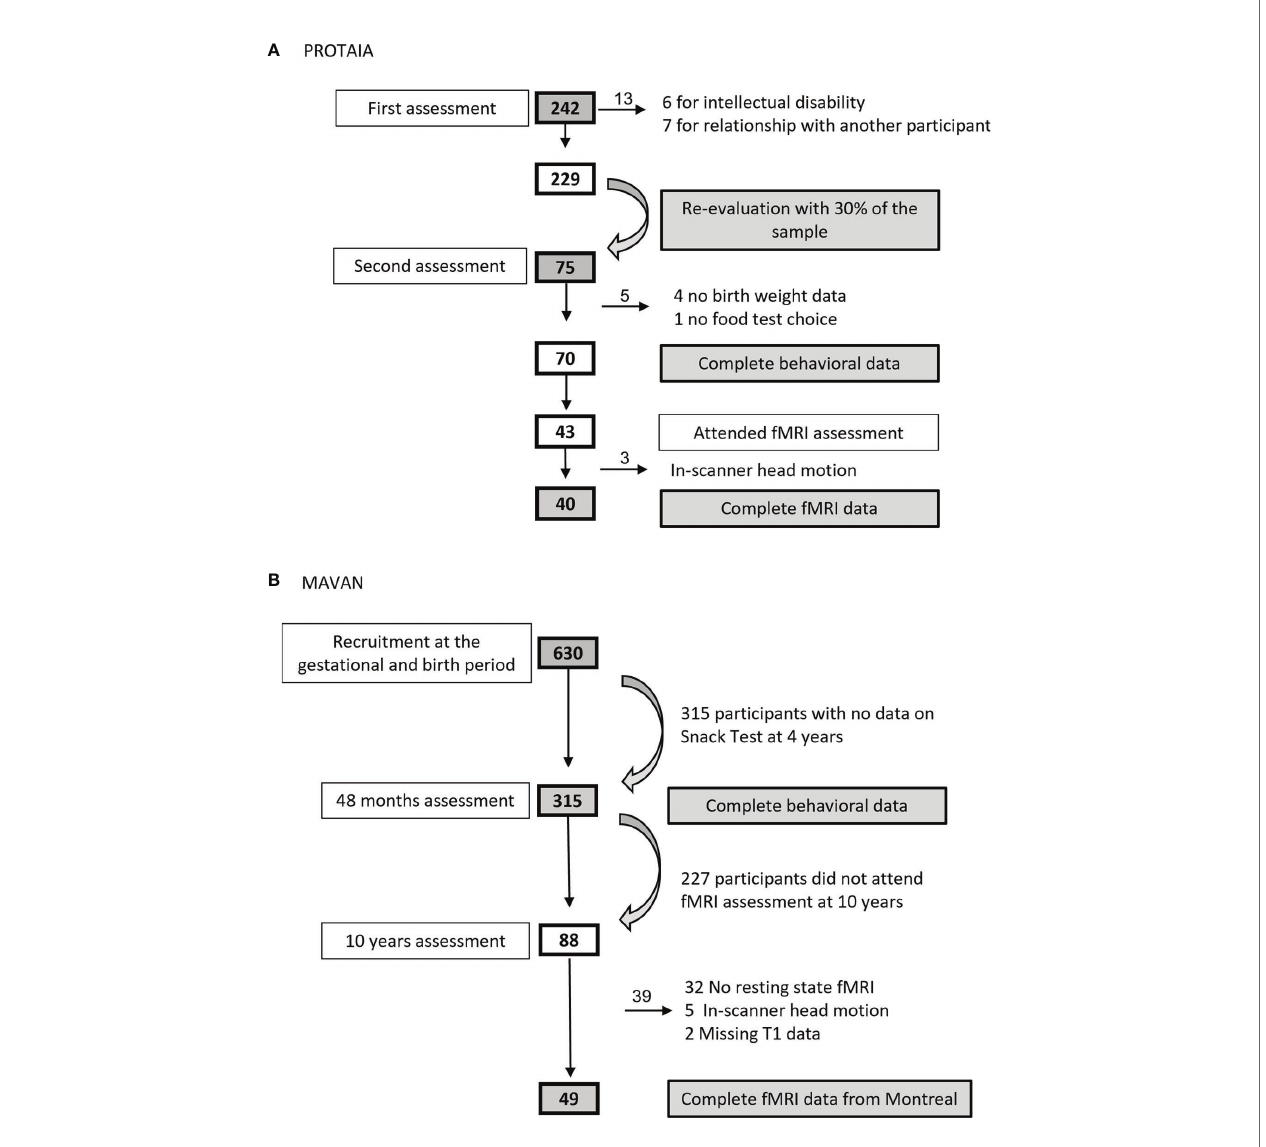
FIGURE 1 | Sample size fl owcharts from (A) PROTAIA and (B)